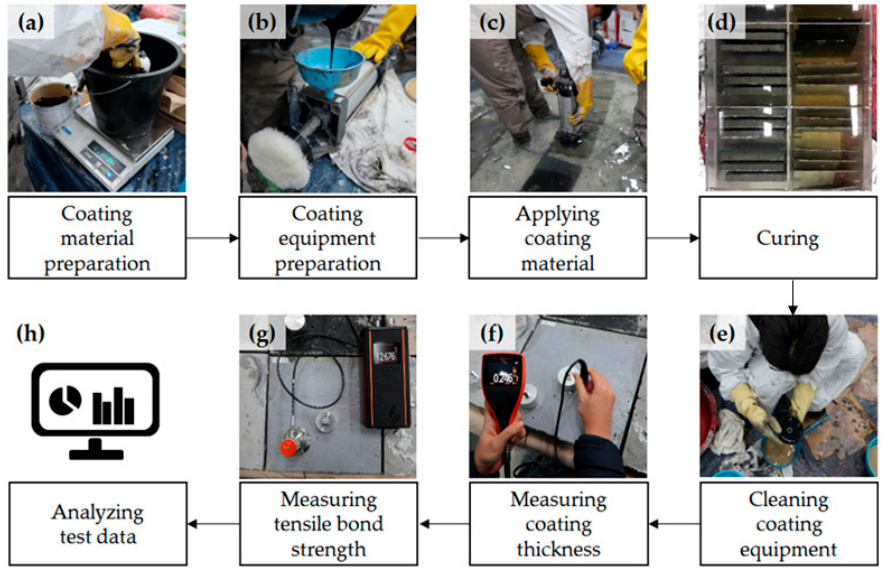
Figure 4. Coating, curing, and measurement process: ( a ) coating material preparation; ( b ) coating equipment preparation; ( c ) applying coating material; ( d ) curing; ( e ) cleaning; ( f ) coating thickness measurement; ( g ) bond strength measurement; ( h ) analyzing.